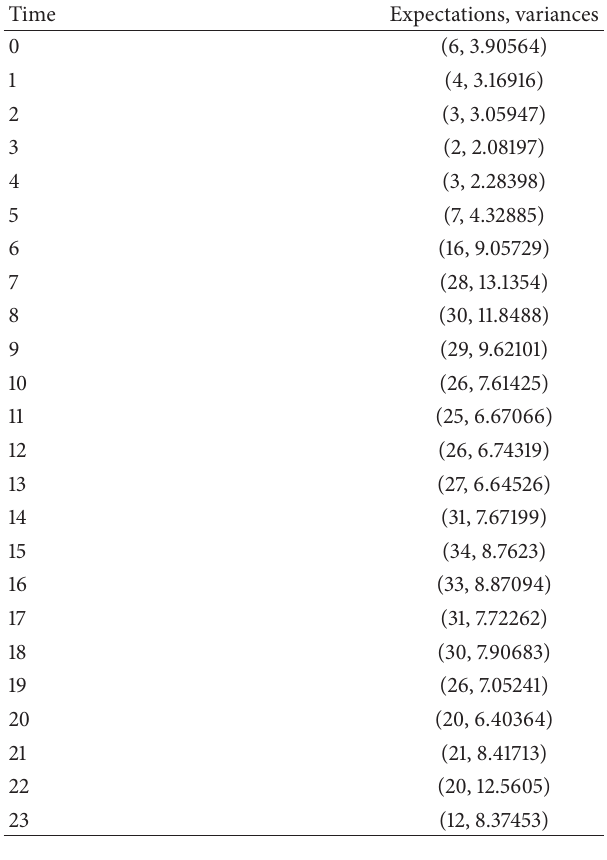
Table 3: The converted normal grey sequence of dataset 2.